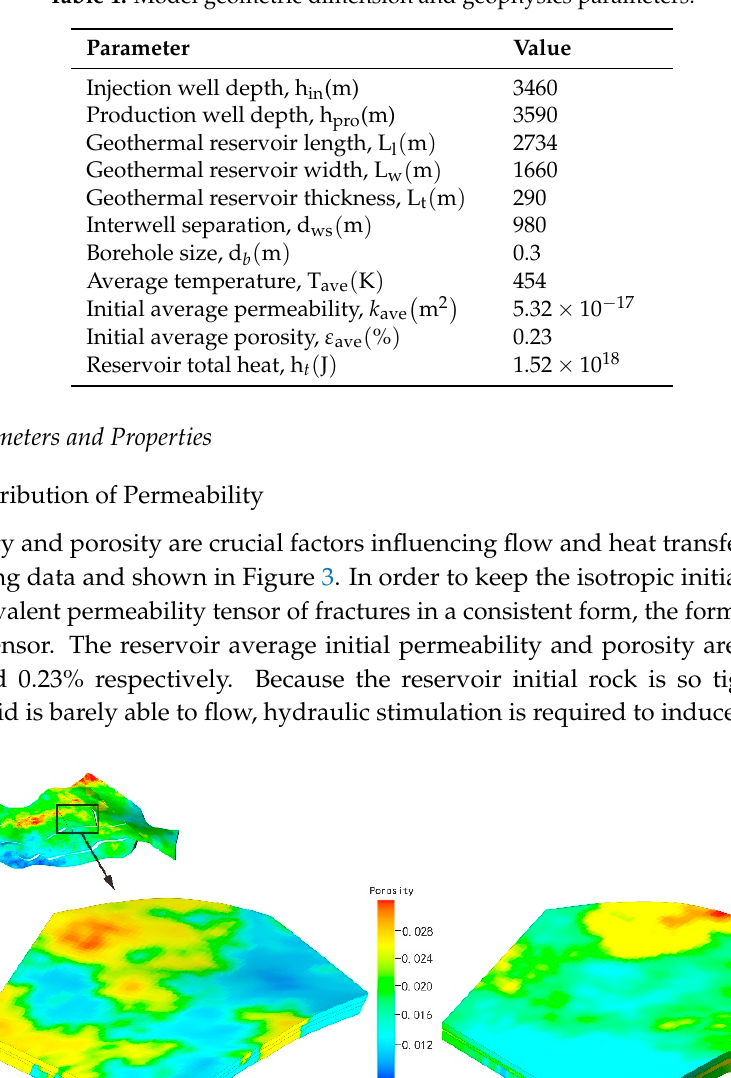
Table 1. Model geometric dimension and geophysics parameters.